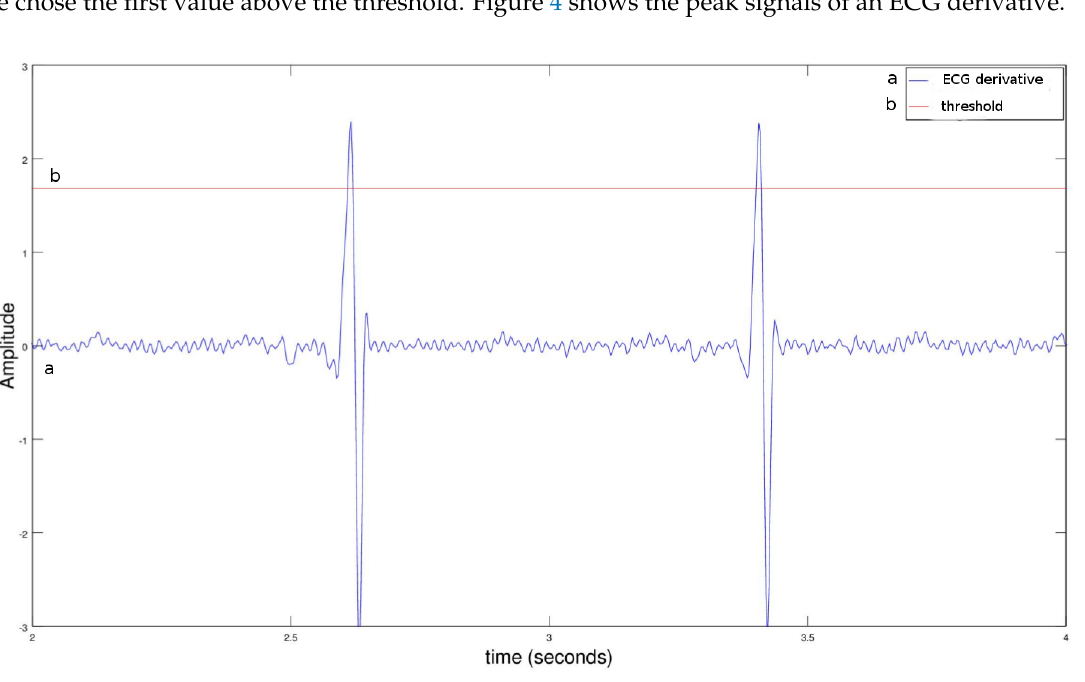
Figure 4. ECG derivative and